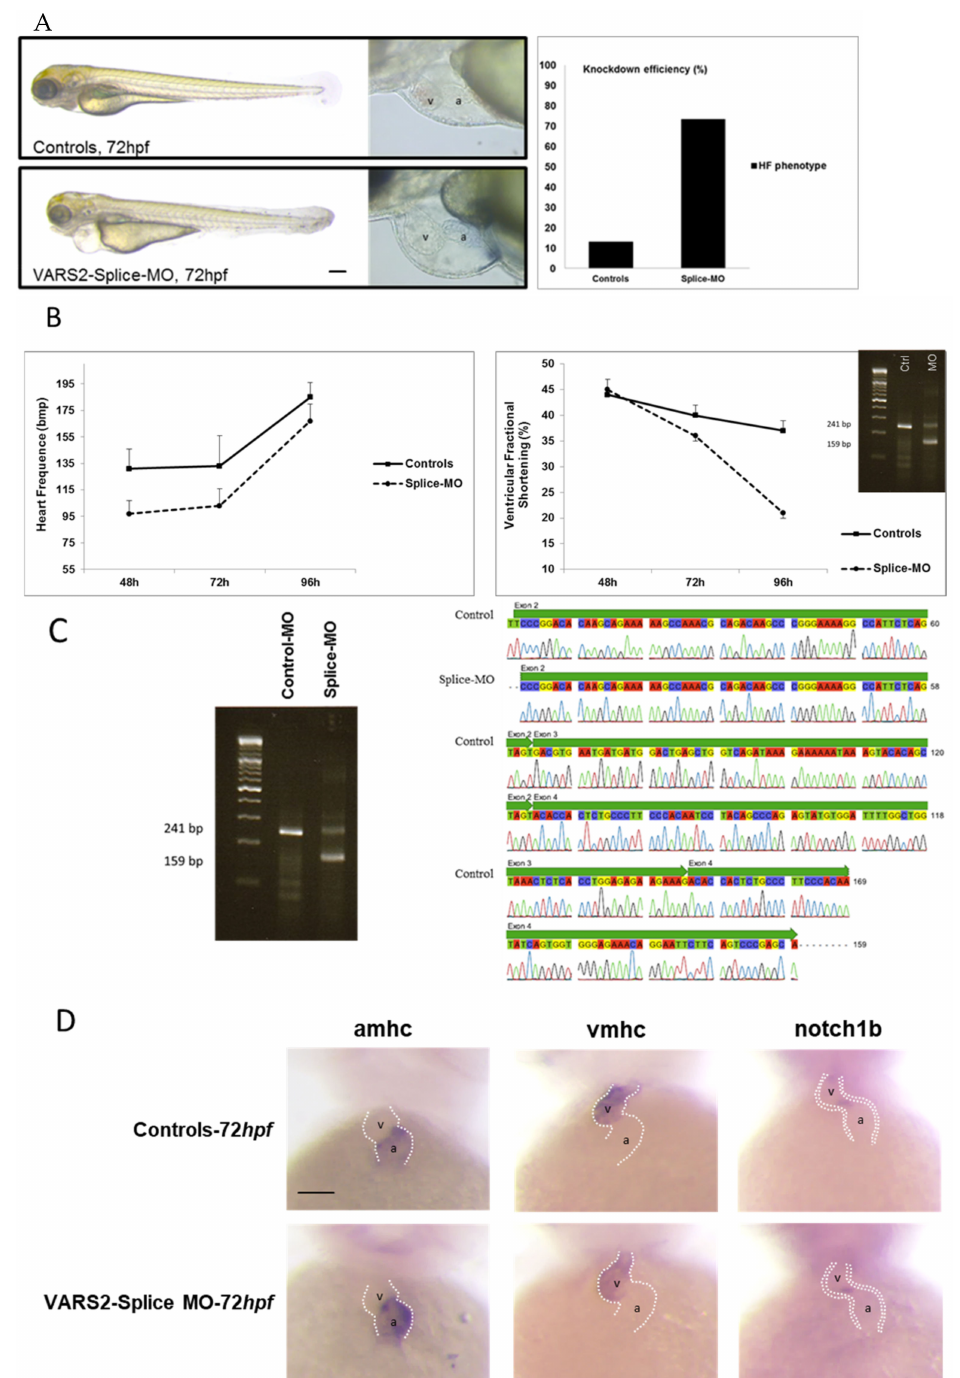
Figure 1. Phenotype of VARS2-MO-injected embryos in comparison to control-MO-injected embryos with 73% knockdown efficiency: n = 100 control-MO- and n = 100 splice-MO-injected embryos. Scale bar: 0.5mm ( A ). Heart rate and ventricular fractional shortening in control-MO- and splice-MO- injected embryos at 48h, 72h, and 96h post-fertilization ( n = 25 each) ( B ). Gel electrophoresis showing a fraction of wild-type cDNA consisting of exons 2, 3, and 4 (241 bp) in control-MO-injected embryos and both wild-type and spliced cDNAs in splice-MO-injected embryos, with spliced cDNA missing exon 3 (159bp) ( C ). Whole-mount RNA antisense in situ hybridization showing expressions of atrial- and ventricle-specific myosin heavy chains as well as notch1b ( D ). v: ventricle, a: atrium, hpf: hours post-fertilization. Scale bar: 100 µ